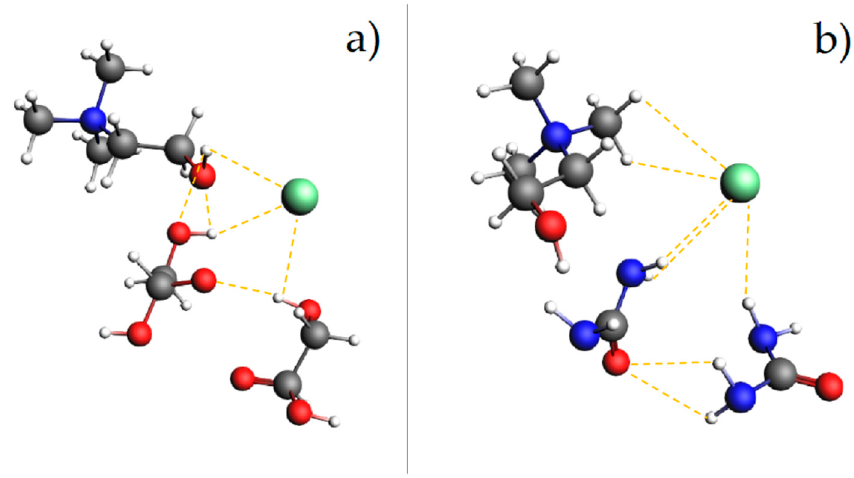
Figure 4. Optimized structures of ( a ) ChCl:OA (1:2), ( b ) ChCl:UA (1:2).